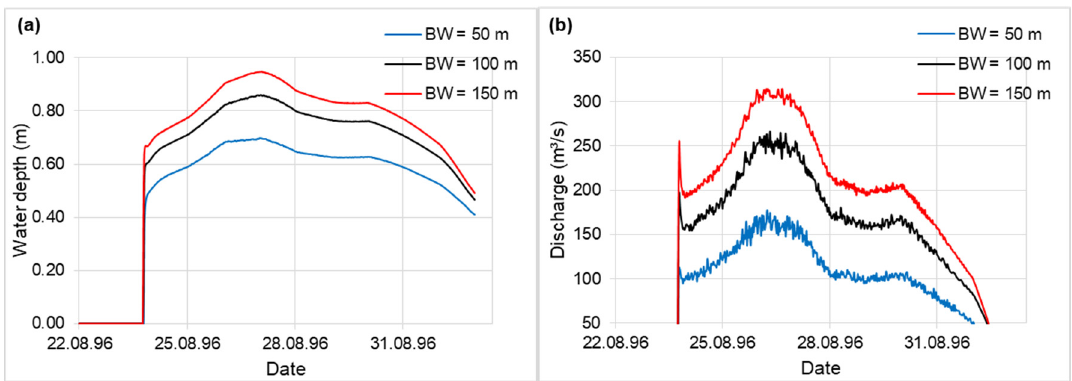
Figure 10. For the indicated final levee breach widths (BW) and the historical levee breach location of the August 1996 levee breach flood event at Wonji, ( a ) modelled water depth at an office location and ( b ) modelled breach discharge. The o ffi ce location and the historical breach location are shown in Figure 3.